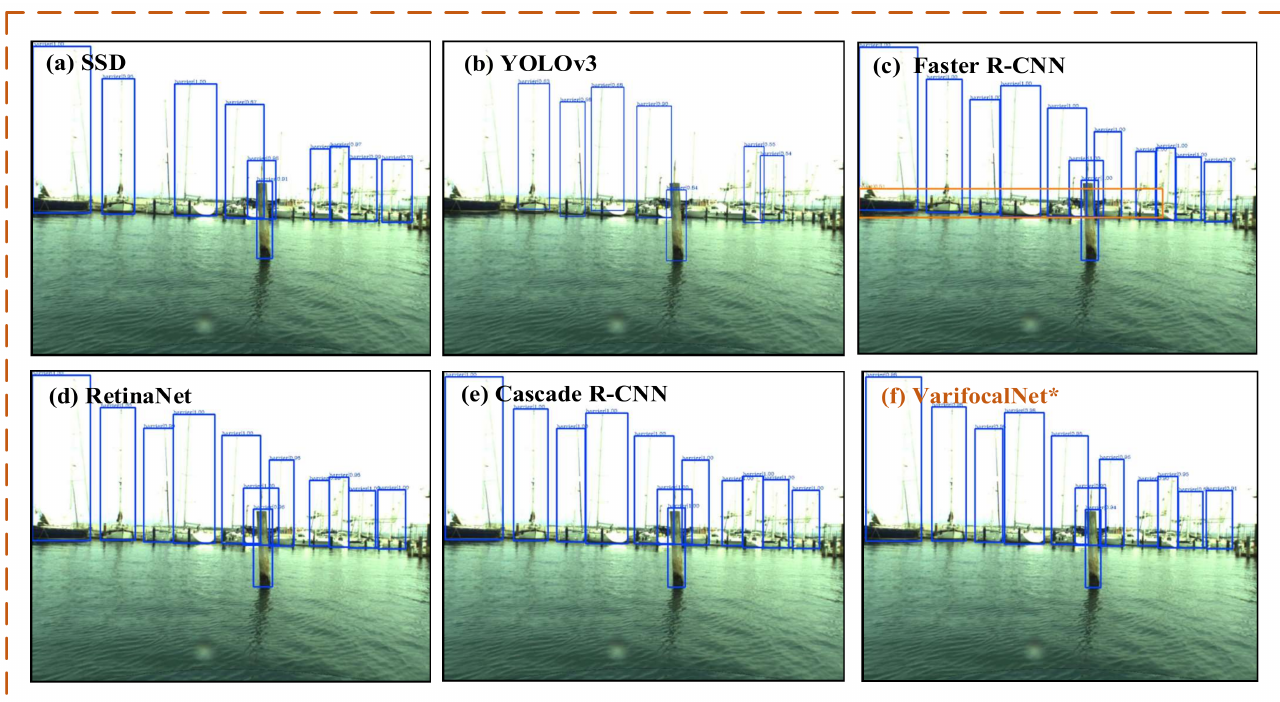
Figure 12. The visual comparisons of different competing methods for detection of sea-surface obstacles under intensive occlusion scene. All ships cannot be detected using SSD and YOLOv3 methods, while there are false detections using Faster R-CNN, as shown in ( a – c ). In ( d – f ), RetinaNet, Cascade R-CNN and VarifocalNet * methods have no missed